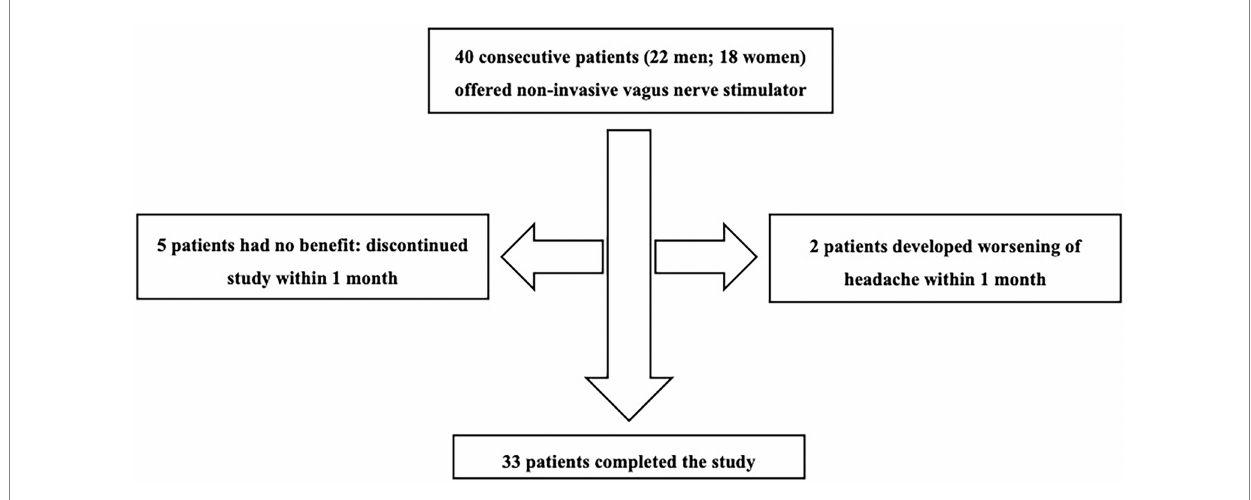
FIGURE 1 Flow of patients through the